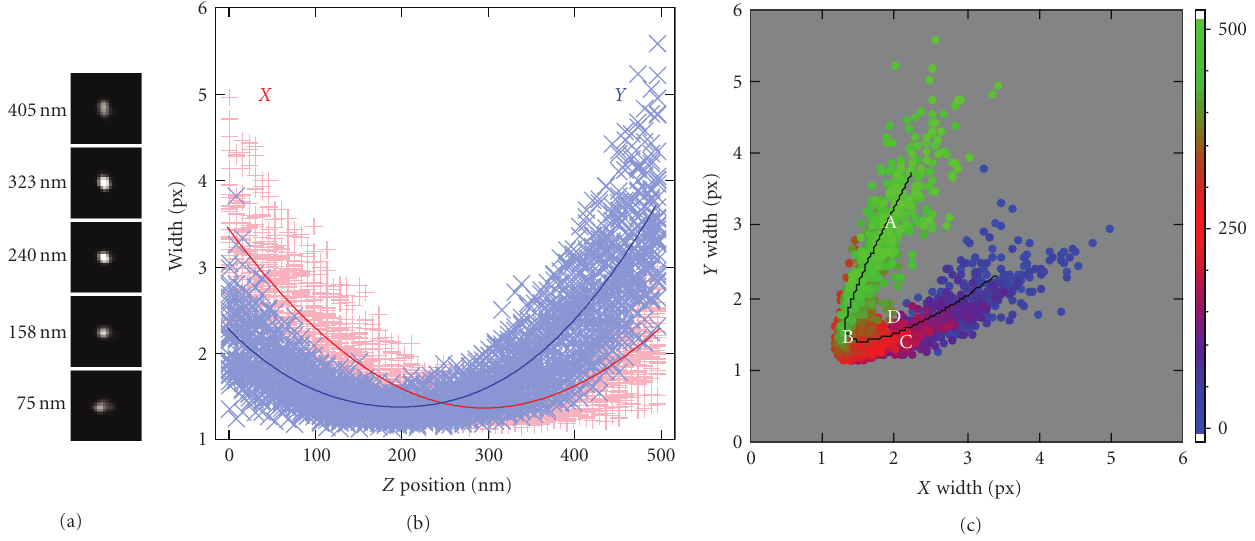
Figure 1: Variation in the lateral bead profile with axial position. (a) Five images of the same 57nm beam taken at di ff erent axial positions demonstrate the astigmatism. (b) The x - and y -widths ( x : red +, y : blue × ) for each height calculated by fitting the bead image to (1). Solid lines are a fit of the width data to the defocusing curve described in (5). (c) Two-dimensional width plot of the same data plotted in (b). Color scale represents the z -position. Letters denote the location of points in the ( σ x , σ y ) plane analyzed and tabulated in Table 1. The solid line is data from the same fit as for (b).